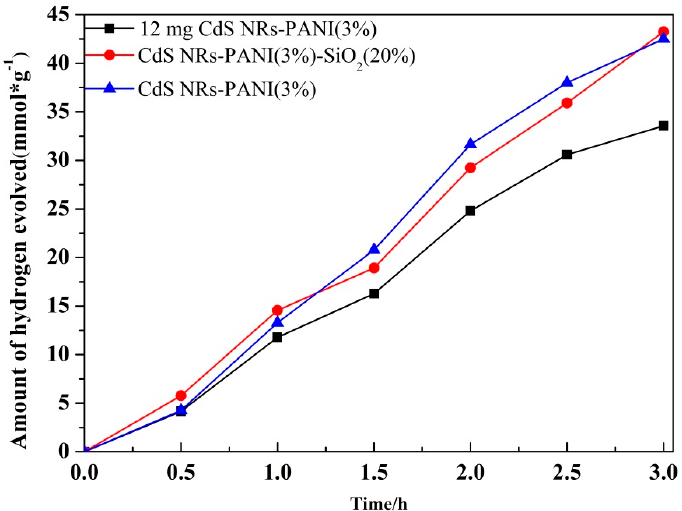
Figure 10. Photocatalytic hydrogen production activity of CdS NRs-PANI (3%)-SiO 2 (20%).